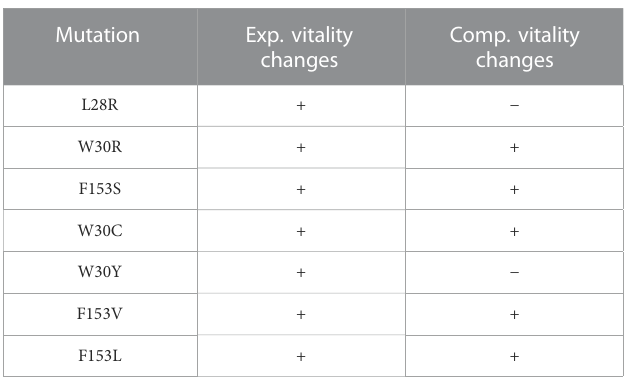
Supplementary Table S3: stability, af fi nity and vitality values for each type at each position. The vitality pro fi le for each position is represented by the logo in Figure 3. Based on vitality, position 23 prefers I, position 29 prefers K or H, position 28 prefers H,